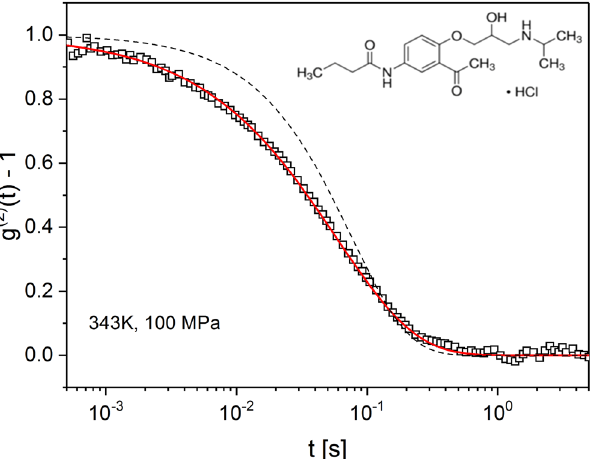
Figure 1. A typical normalized DLS time correlation function measured for ACB-HCl at 343 K and 100 MPa (points). The red solid line represents the KWW fit to the data. The dashed black line shows a simple exponential function to visualize the broadening of relaxation times